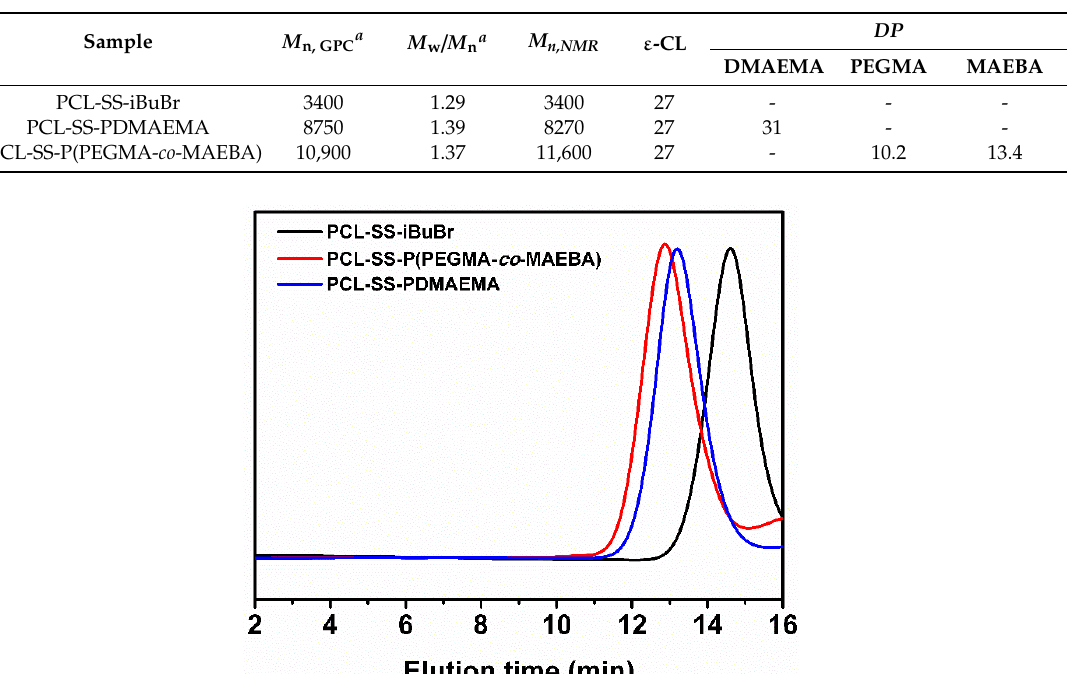
Table 1. 1 H NMR and GPC data of the copolymers PCL-SS-PDMAEMA, PCL-SS-P(PEGMA- co -MAEBA) and their precursor PCL-SS-iBuBr.